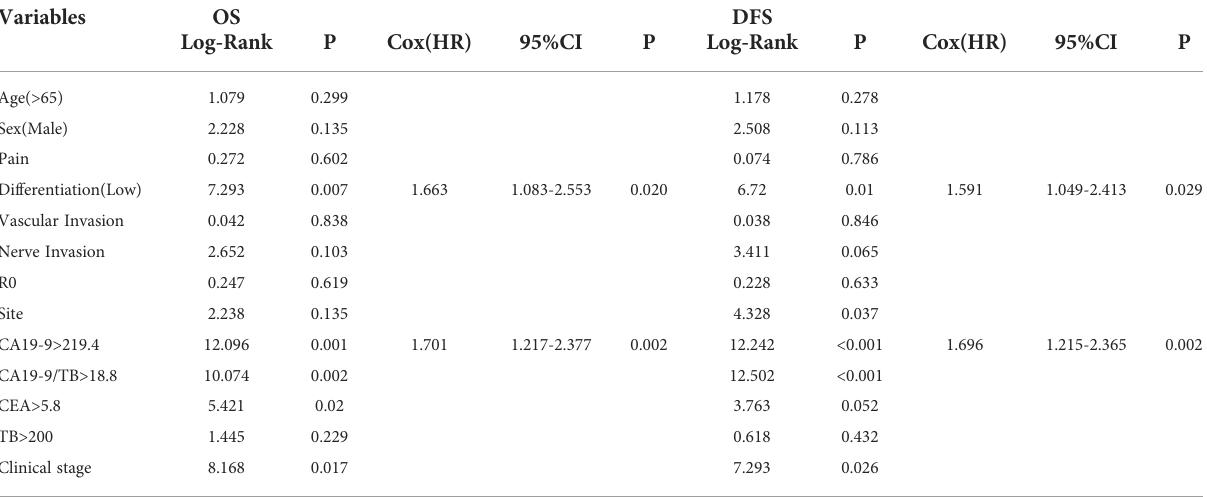
TABLE 2 Risk factors affecting survival.